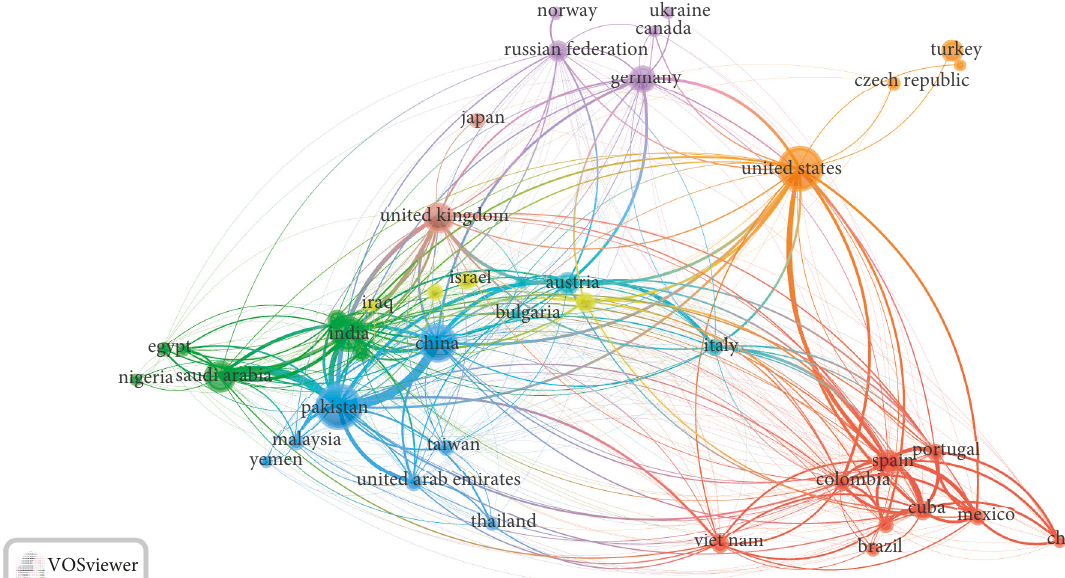
Figure 2: Bibliometric analysis of countrywide research based on the topic of entropy. The size of the circles denotes the frequency of articles, and distinct colors are used to signify distinct